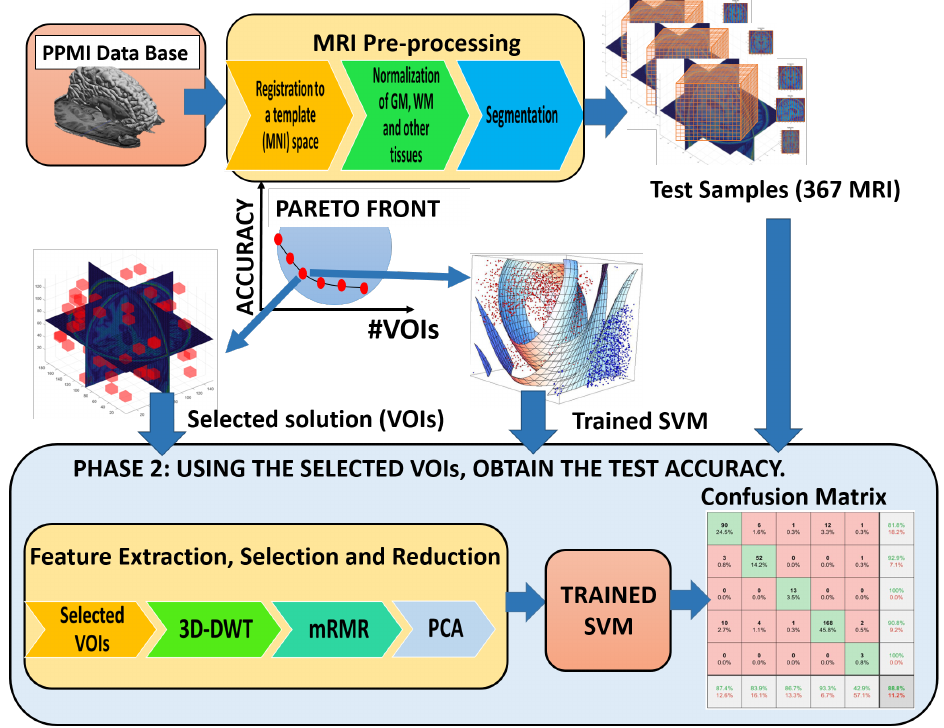
Figure 2. Phase 2: Block scheme for the test phase. Selected VOIs from the Pareto Front are used to construct the SVM